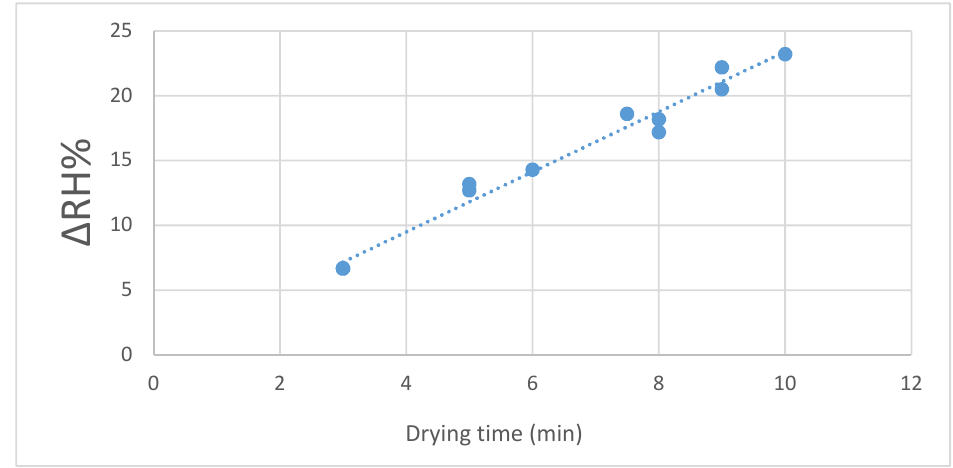
Figure 1. Relationship between the IR drying time and the relative humidity loss (ΔRH%) at 40 °C.